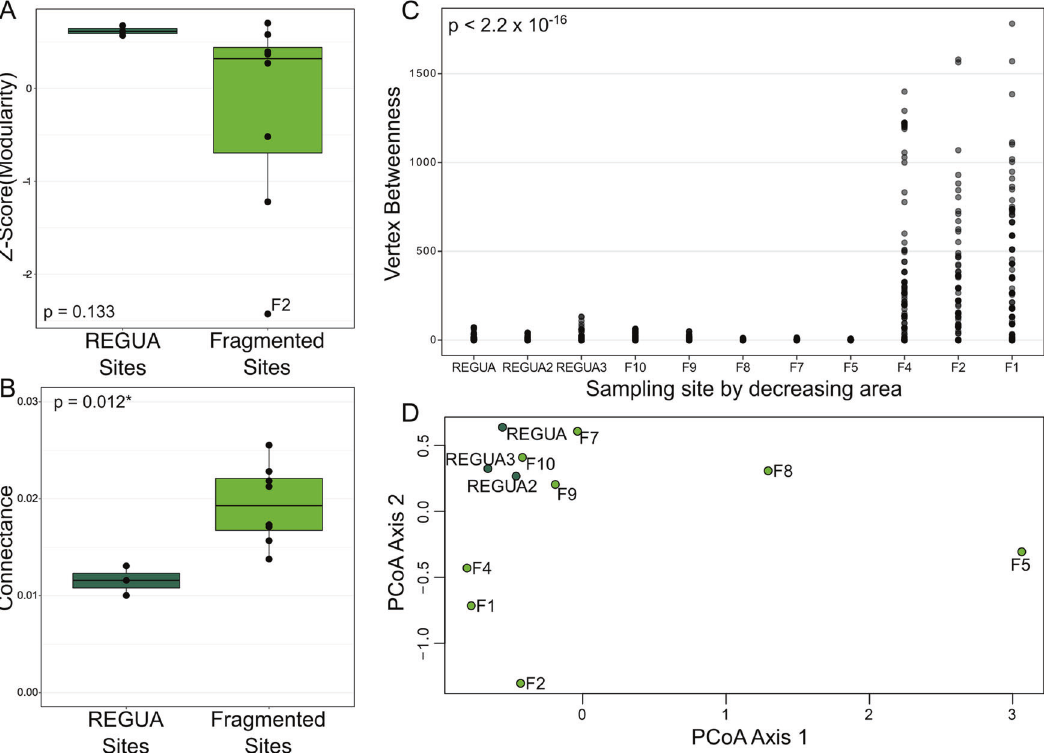
Fig. 5 Summary statistics of network plots. Z-score modularity of habitat patch networks between REGUA and outside-REGUA sites ( A ), network connectance of habitat patch networks in REGUA and outside-REGUA sites ( B ), vertex betweenness centrality by fragment decreasing by habitat patch area ( C ), principal coordinates analysis of the distribution of network orbits for habitat patch networks ( D ). Dark green corresponds to REGUA sites and lime green corresponds to sites outside of REGUA for which networks were